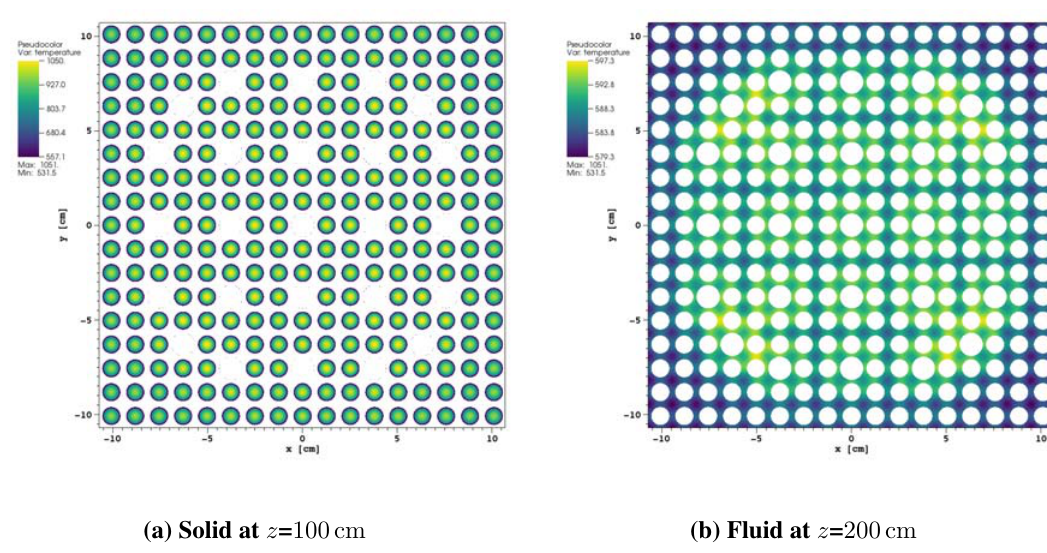
Figure 6: Temperature distribution as calculated by